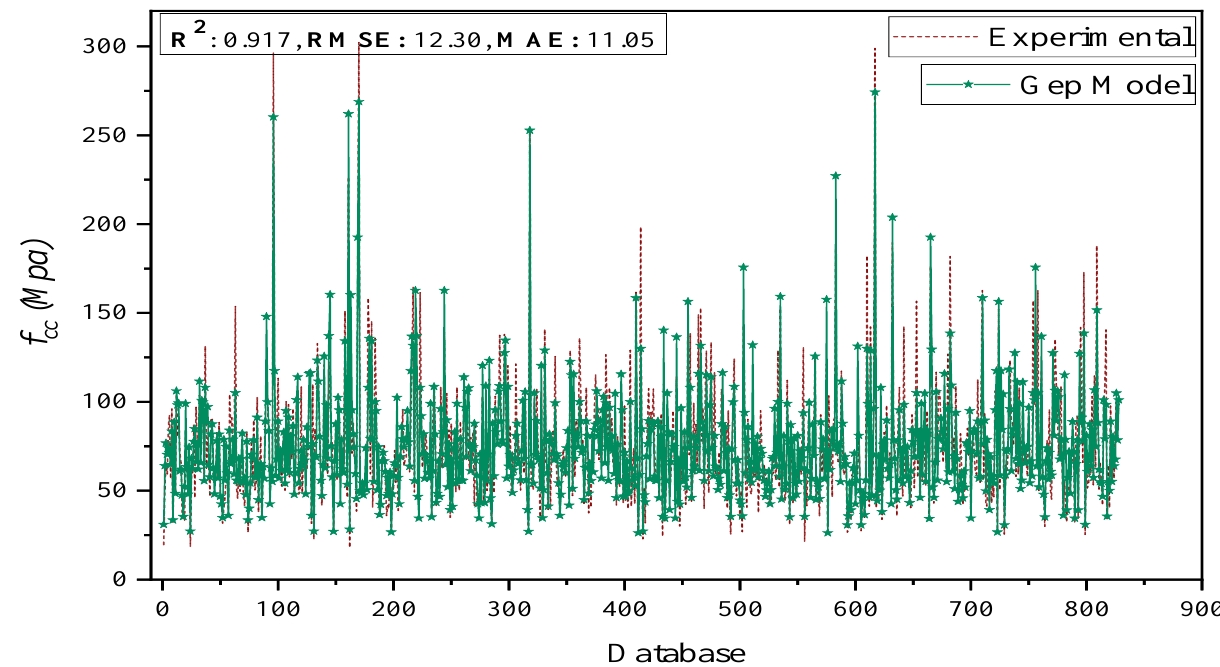
Figure 4. Forecasting via GEP against actual output.